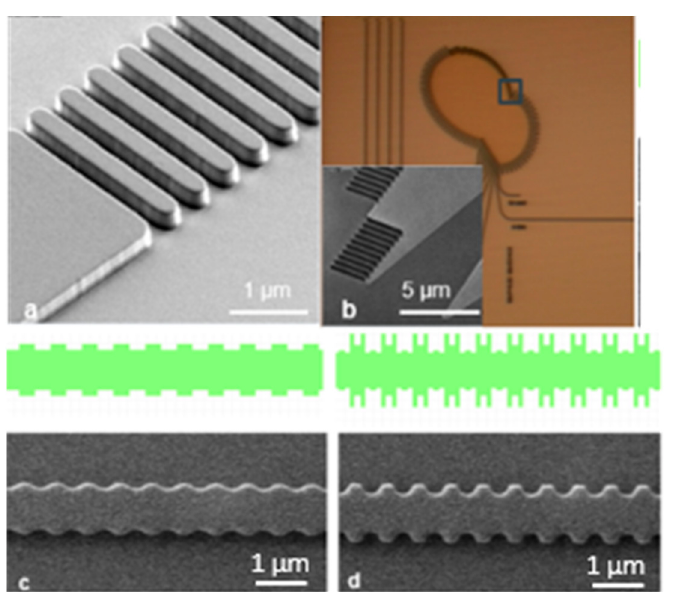
Figure 9. ( a ) Waveguide with a vertically modulated DBR and ( b ) optical micrograph of an Echelle grating. Inset—SEM of vertically modulated DBR in the selected square. ( c , d ) Waveguide with a lateral DFB grating. Top—layout and bottom—SEM micrographs show that OPC improves the corners of the lateral grid.